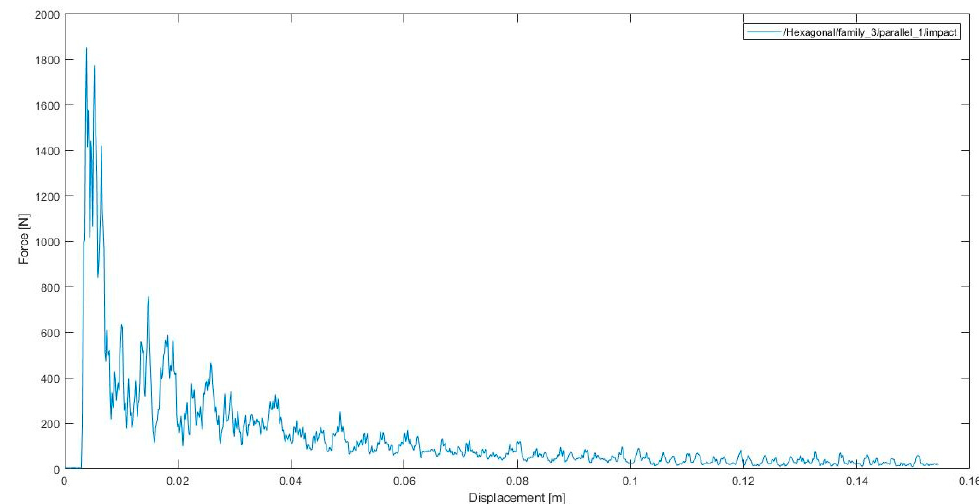
Figure 3. Force versus displacement for hexagonal family 3 with an impact direction parallel to the build direction. The chessboard pattern, row 14 (laser power 596.85 mm/s, hatch spacing 0.075